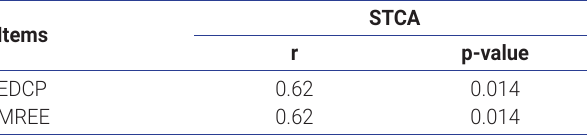
Table 5. Correlation between FTIR carbohydrate structures and the DVE/OEB system for canola meals Items